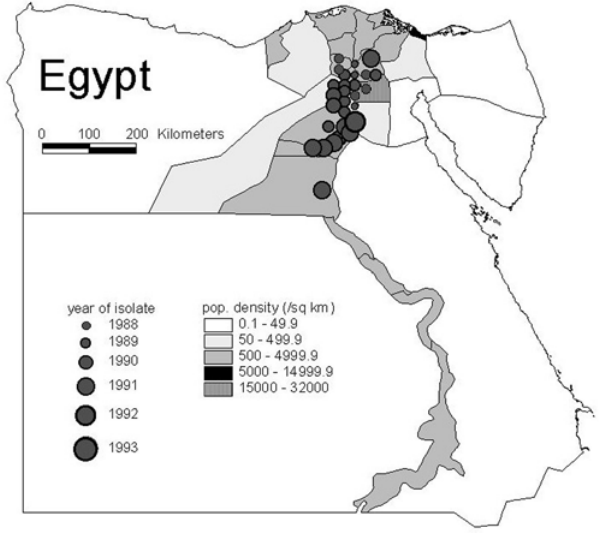
Figure 5 . Geographic distribution of virologically-confirmed type 2 cVDPV cases in Egypt between 1988 and 1993. Individual cases are represented by filled circles of different sizes to show the year of paralysis onset. Population density for Egypt in 1990 is shown by governorate.